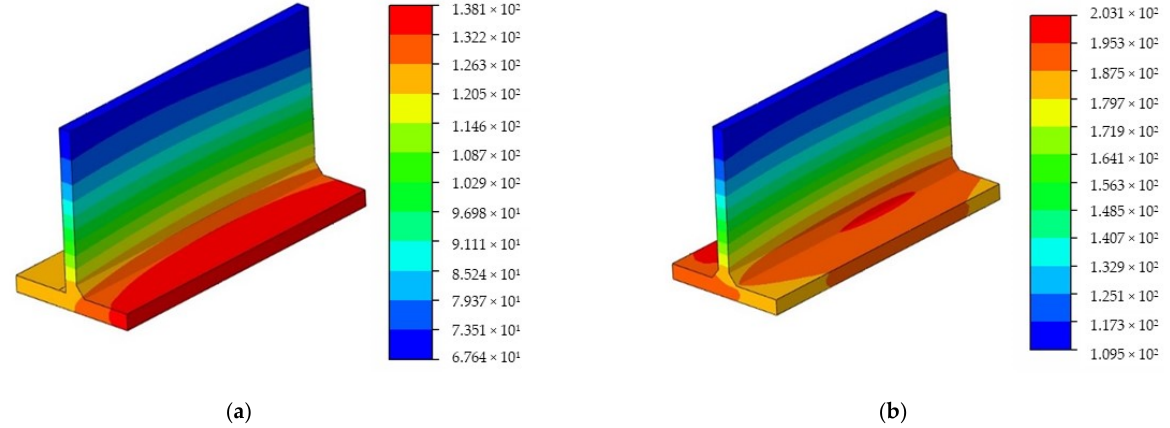
Figure 6. Transient temperature field: ( a ) 400 s and ( b ) 800 s after the start of the welding process (unit: °C).